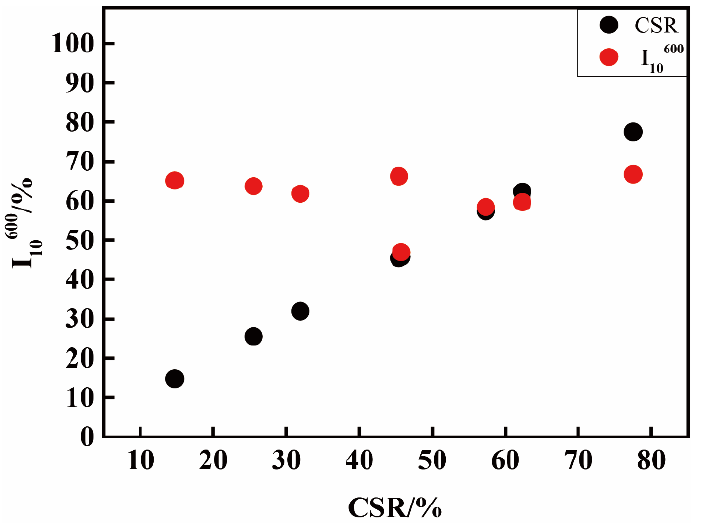
Figure 1. The comparison of I 10600 under T5 with CSR under T1 of cokes from single coals. Furthermore, the values of I 10600 under T5 minus CSR under T1 (I 10600 -CSR) vs. CRI are shown in Figure 2. It appears that the (I 10600 -CSR) values increase with the increase in CRI, and a line relation may exist, indicating that for cokes with high CRI from high volatile coals, a strong resistance capacity of strength deterioration appears at high temperatures. Figure 2. The ( I 10600 -CSR) vs. CRI of cokes.